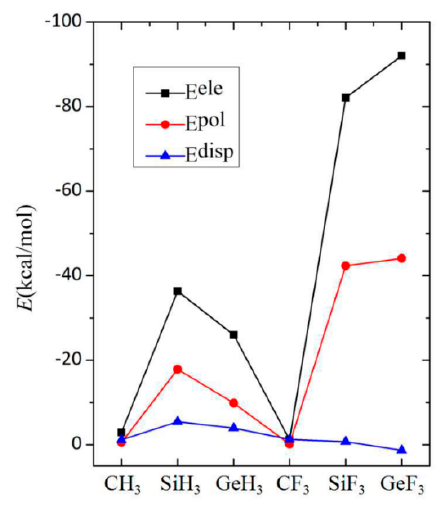
Figure 5. Dependence of three attractive energies on the TX 3 group (T = C, Si, and Ge; X = H and F).